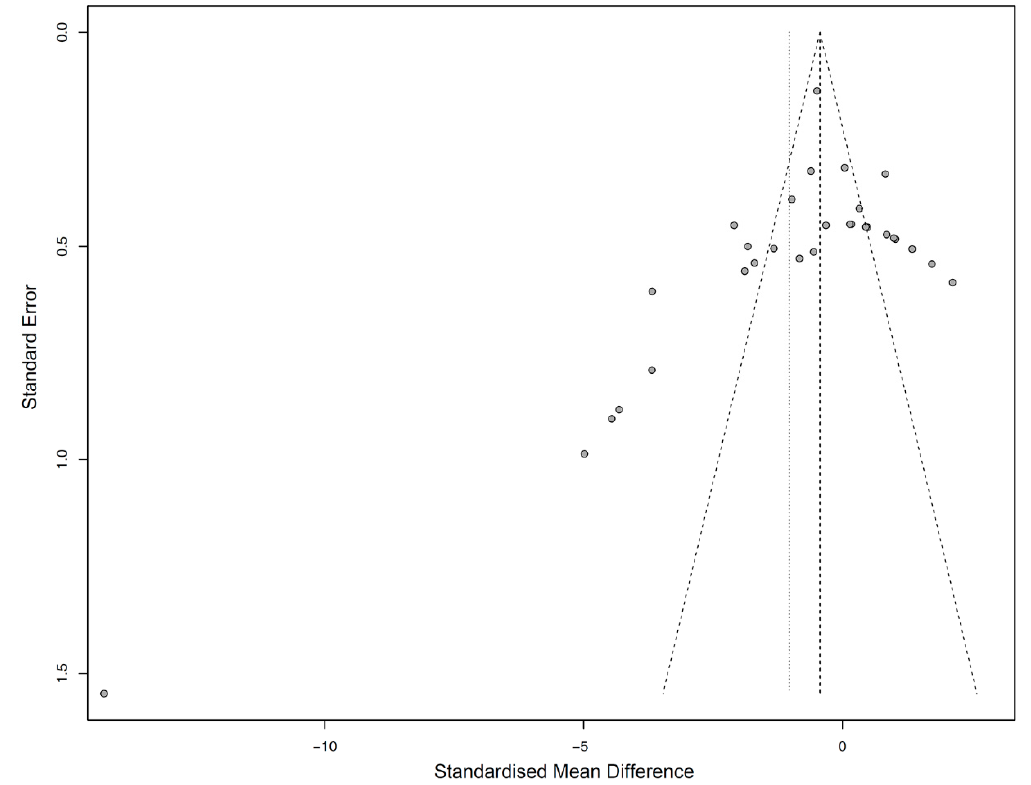
Figure 6. Funnel plot showing publication bias assessment.